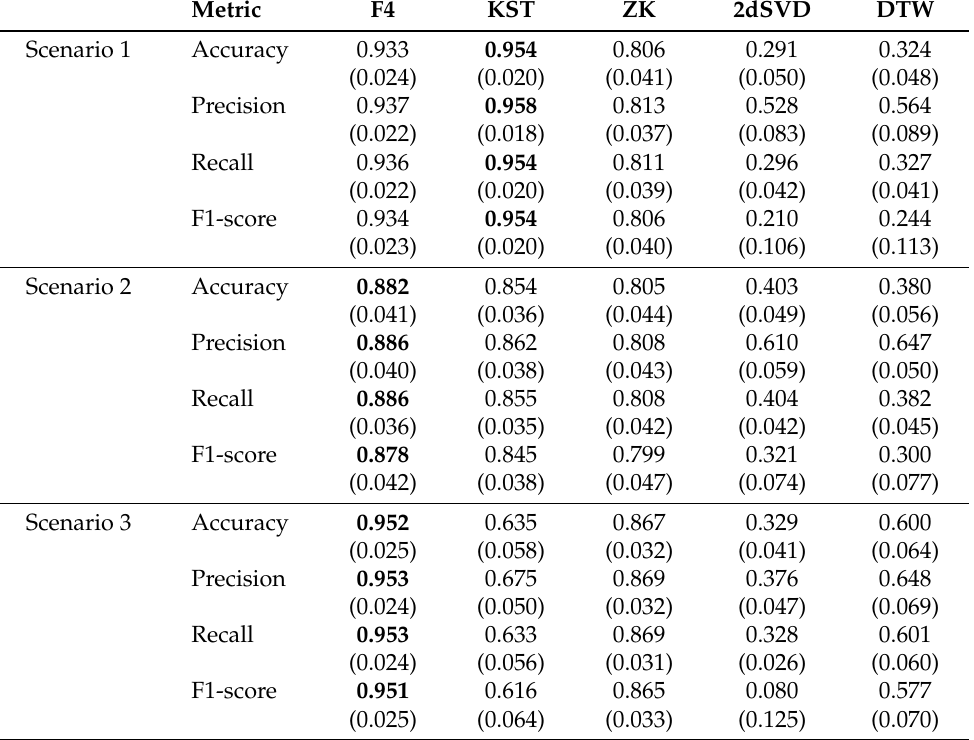
Table 3. Averages and standard deviations (in brackets) of the performance metrics for the five classifiers in Scenarios 1, 2 and 3. For each scenario and metric, the best average result is shown in